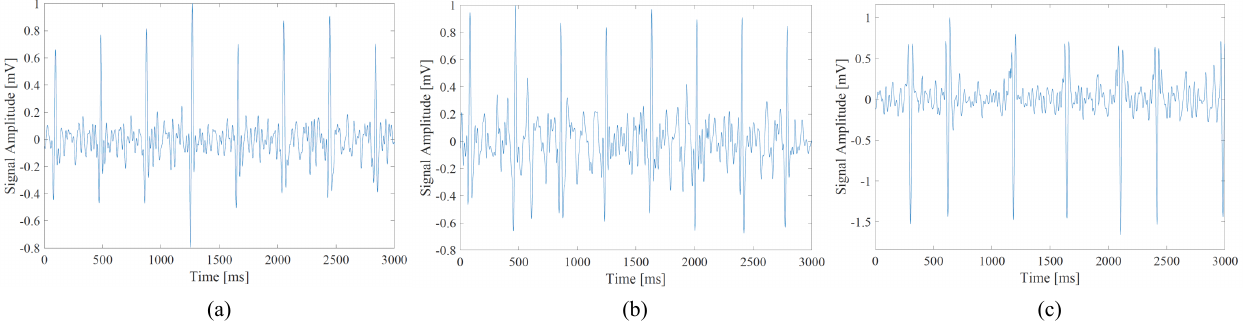
Figure 5. The labeled segments. ( a ) normal FECG segment; ( b ) moderate FECG segment; and ( c ) arrhythmia FECG